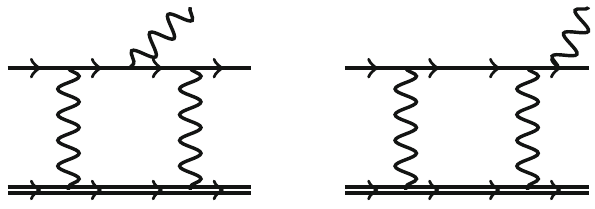
Fig. 6 Examples of Feynman diagrams ∼ q 3 Q 2 contributing to the real-virtual corrections to μ - e scattering at NNLO in QED. Related diagrams ∼ q 2 Q 3 , where the real photon is radiated from a muonic line, can be obtained from these by means of